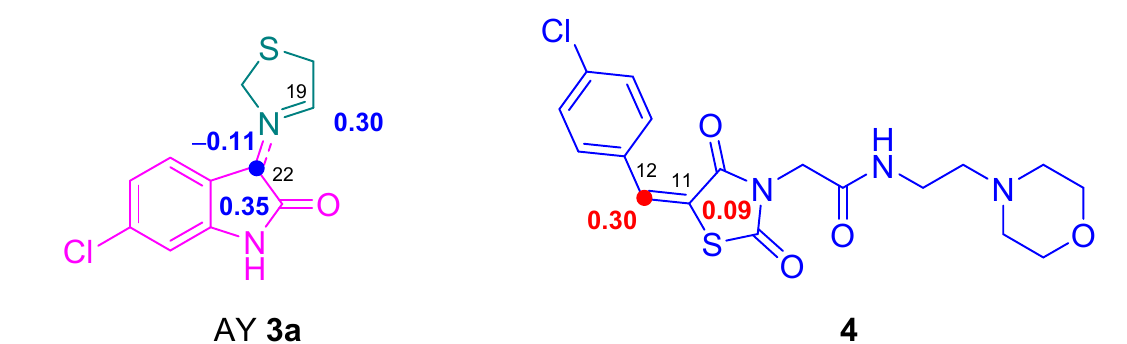
Figure 9. B3LYP/6-31G(d) nucleophilic Parr functions, in blue, of AY 3a , and electrophilic Parr functions, in red, of the ethylene derivative 4 .